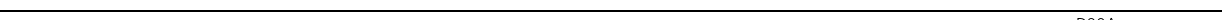
Fig. 7 Validation of dysregulated transcripts within the EphB1 – STAT3 network and the failure of STAT3 activation in human SOD1 D90A iPSC-astrocytes. a Diagram of selection criteria for validation of gene expression data. b Graph indicates mean fold changes of mRNA of top transcripts when normalised to controls ( n = 8 control and 7 SOD1-mutant independently converted hiPSC-astrocyte (AC) cultures, Supplementary Table 1; **** p ≤ 0.0001, ** p = 0.003; unpaired t -test). c Graphs show mean fold changes of increased protein levels normalised to the mean of controls when measured by mass spectrometry (MS) ( n = 3 independent cultures of SOD1-mutant hiPSC-astrocytes vs. control astrocytes; ** p = 0.003, * p = 0.039, ** p = 0.0015, unpaired t -test). d PHLDA3 IR pattern in ALDH1L1/DAPI-labelled control and SOD1-mutant hiPSC-astrocytes. e Dot plot graph shows integrated density measurements of nuclear PHLDA3 IR in astrocytes after normalised to background. N = 378 cells from three SOD1 patient-derived hiPSC-astrocytes and 181 cells from two control patients; **** p ≤ 0.0001, unpaired t -test. f Graphs shows mean fold changes of decreased protein levels normalised to the mean of controls when measured by MS ( n = 3 independent cultures of SOD1-mutant hiPSC-astrocytes vs. control astrocytes, *** p = 0.0001, ** p = 0.009, ** p = 0.003, unpaired t -test). g Panels demonstrate immuno fl uorescence images of GFAP-positive astrocytes with nSTAT3 IR in control and in SOD1 hiPSC-astrocytes. Adjacent panels with DAPI staining illustrate nSTAT3 co-localisation (arrows). h – k Graphs represent the proportion of nSTAT3-positive cells among the total of GFAP-positive astrocytes in control ( h ) or SOD1-mutant hiPSC-cultures ( i ), which is also independently analysed for the isogenic corrected control/SOD1- mutant pair of hiPSC-astrocyte cultures ( j , k ). For h and i , n = 13 and 9 independently converted hiPSC-astrocyte cultures; ** p = 0.002, * p = 0.029 for controls, ** p = 0.003 for SOD1 hiPSC-astrocytes, one-way ANOVA with Bonferroni test. For j and k , n = 2 independently converted astrocyte cultures for the isogenic control and n = 3 for the SOD1-mutant pair; * p = 0.027 for IL-6 and * p = 0.038 for EphB1 in controls; * p = 0.025 for IL-6 and p = 0.777 for EphB1 in SOD1 astrocytes; F = 21.95 and F = 7.8, respectively; one-way ANOVA with Bonferroni test. Data expressed as ± SEM. Scale bar: 30 μ